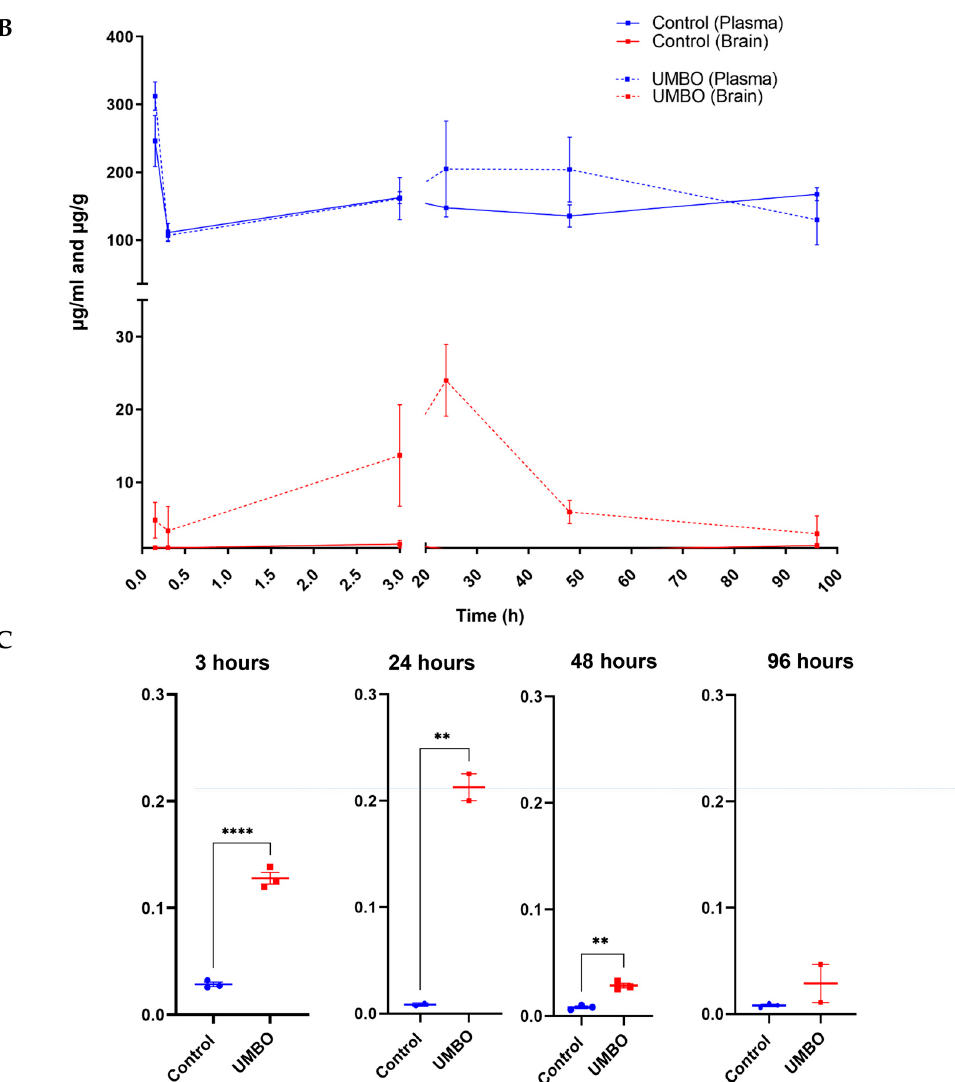
Figure 4. UMBO increased the delivery of ICIs to the brain parenchyma. (Panel A ): IHC staining of anti-PD-L1 (BXCELL) (Panel B ): PK of Nivolumab concentration in the C57BL/6 mice blood and brain. (Panel C ): Brain/plasma ratio of nivolumab concentration over time. UMBO enhanced the brain/plasma ratio of nivolumab compared to control mice. ** for p ≤ 0.01. **** for p ≤ 0.0001.